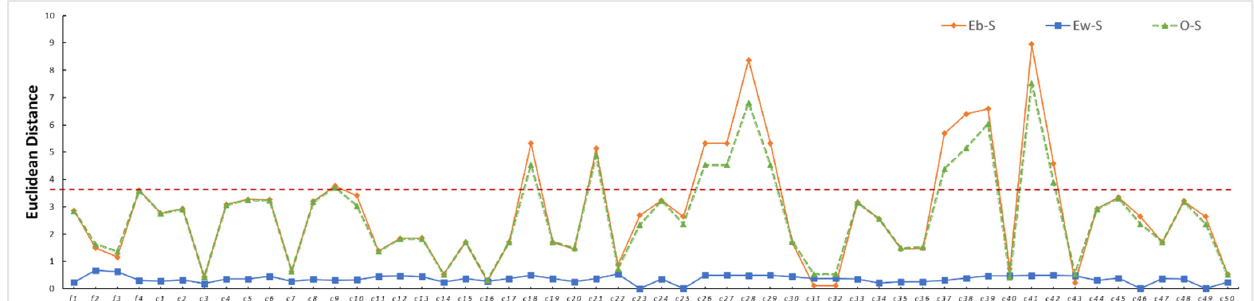
Figure 7. Euclidean distances between the eddies, oil film, and seawater under the CP feature of data #B. The y -axis is the Euclidean distance, and the x -axis indicates the features ( f 1 –f 4 are σ HH , σ HV , σ VH , and σ VV , respectively, and c 1 –c 50 corresponding features are shown in Table 2). Eb-S is the Euclidean distance between the black spiral of the eddy and the seawater, Ew-S is the Euclidean distance between E W and the seawater, and O-S is the Euclidean distance between the oil film and the clean seawater. The red dashed line indicates the Euclidean distance between the eddies and the ocean background in the σ VV image, which is different from that of the B-E.